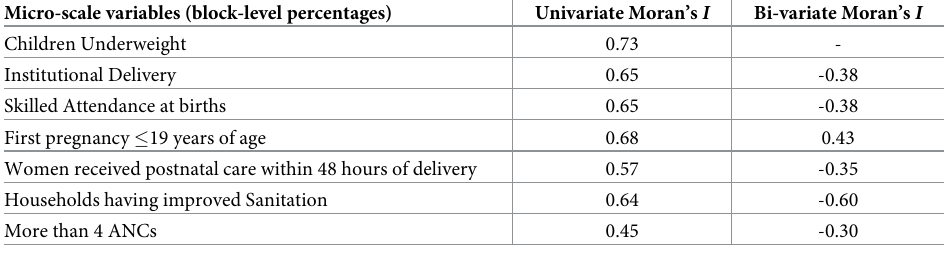
Table 3. Univariate and bivariate Moran’s I statistics of the prevalence of children underweight and its micro- scale correlates in Odisha, CCM-II, 2014–15.